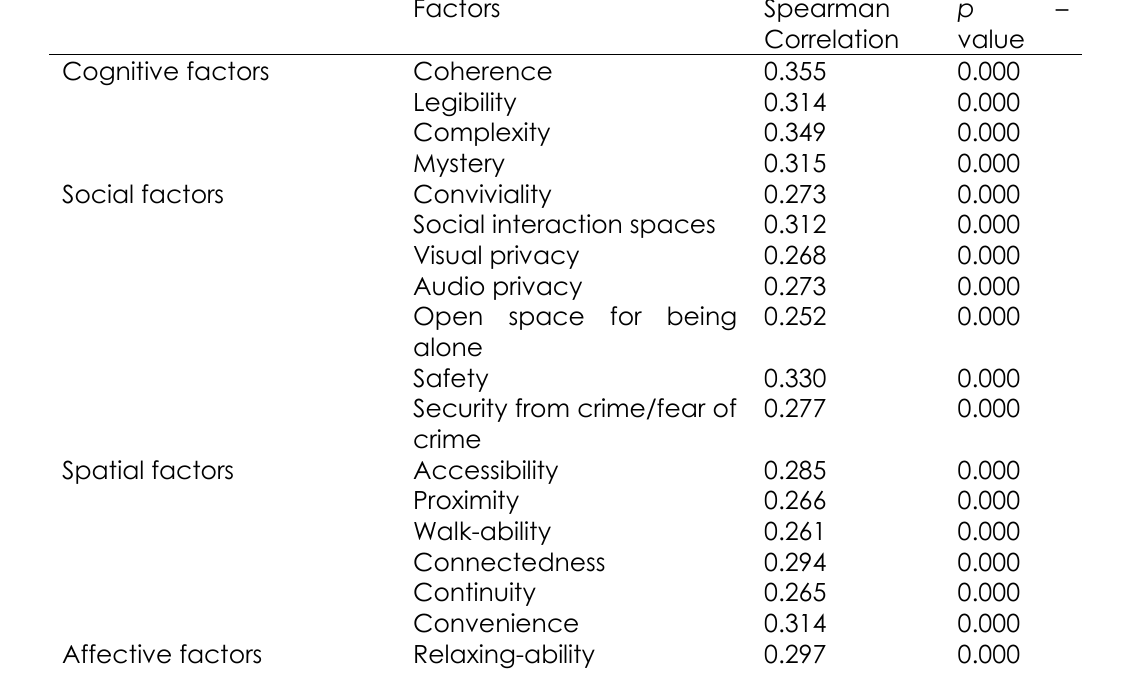
Table 7. Factors influencing users’ satisfaction with the University Zoological gardens in the study